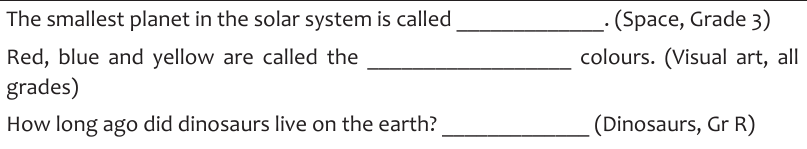
Figure 3: Questions designed to measure teachers’ content knowledge in ‘beginning